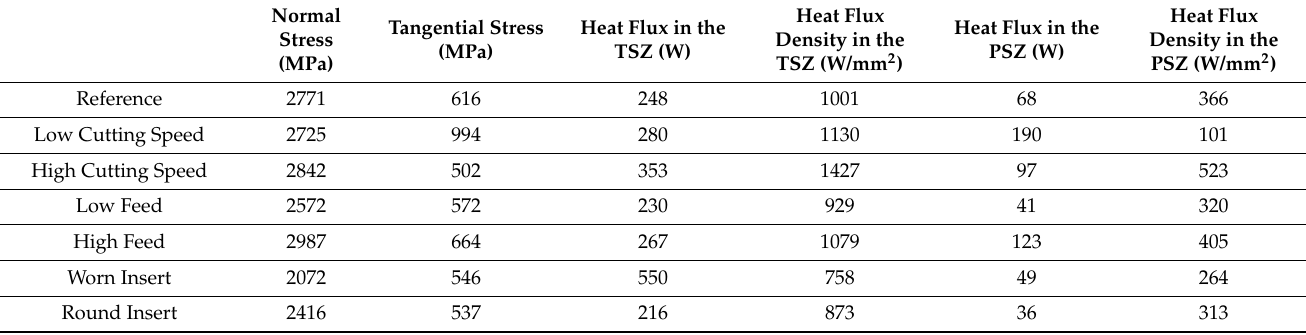
Table 8. Maximum values of equivalent thermomechanical